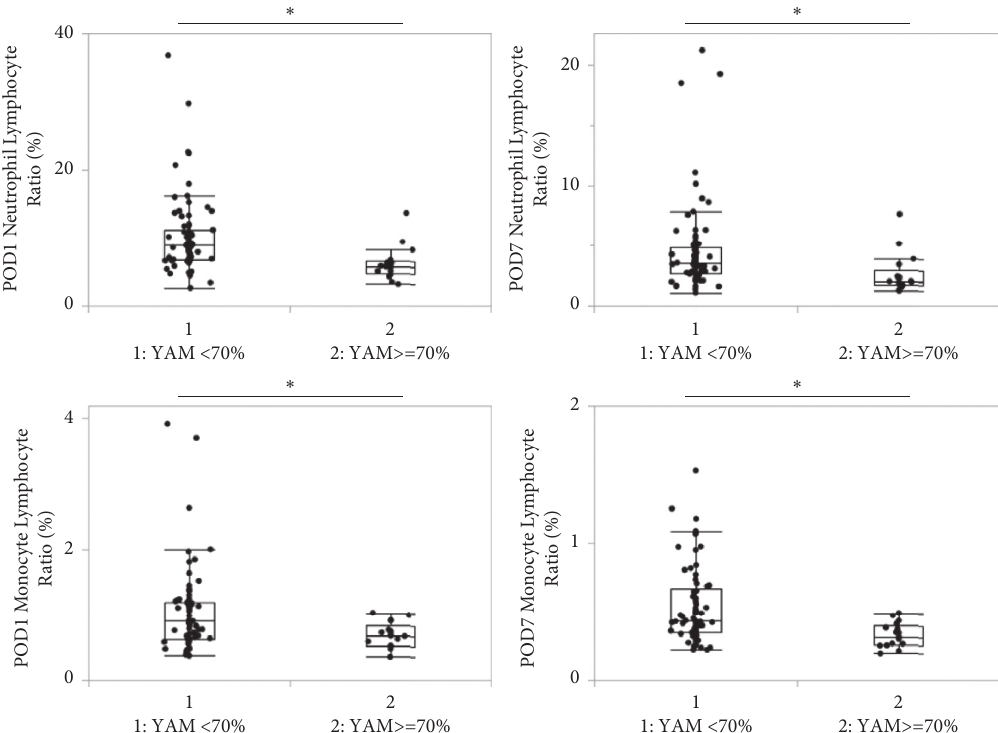
Figure 1: Comparison of neutrophil lymphocyte ratio (NLR) and monocyte lymphocyte ratio (MLR) according to a young adult mean (YAM) cutoff of 70%. Patients with YAM > 70% had lower NLR and MLR values on postoperative day (POD) 1 and POD 7. ∗ P < 0 . 01.